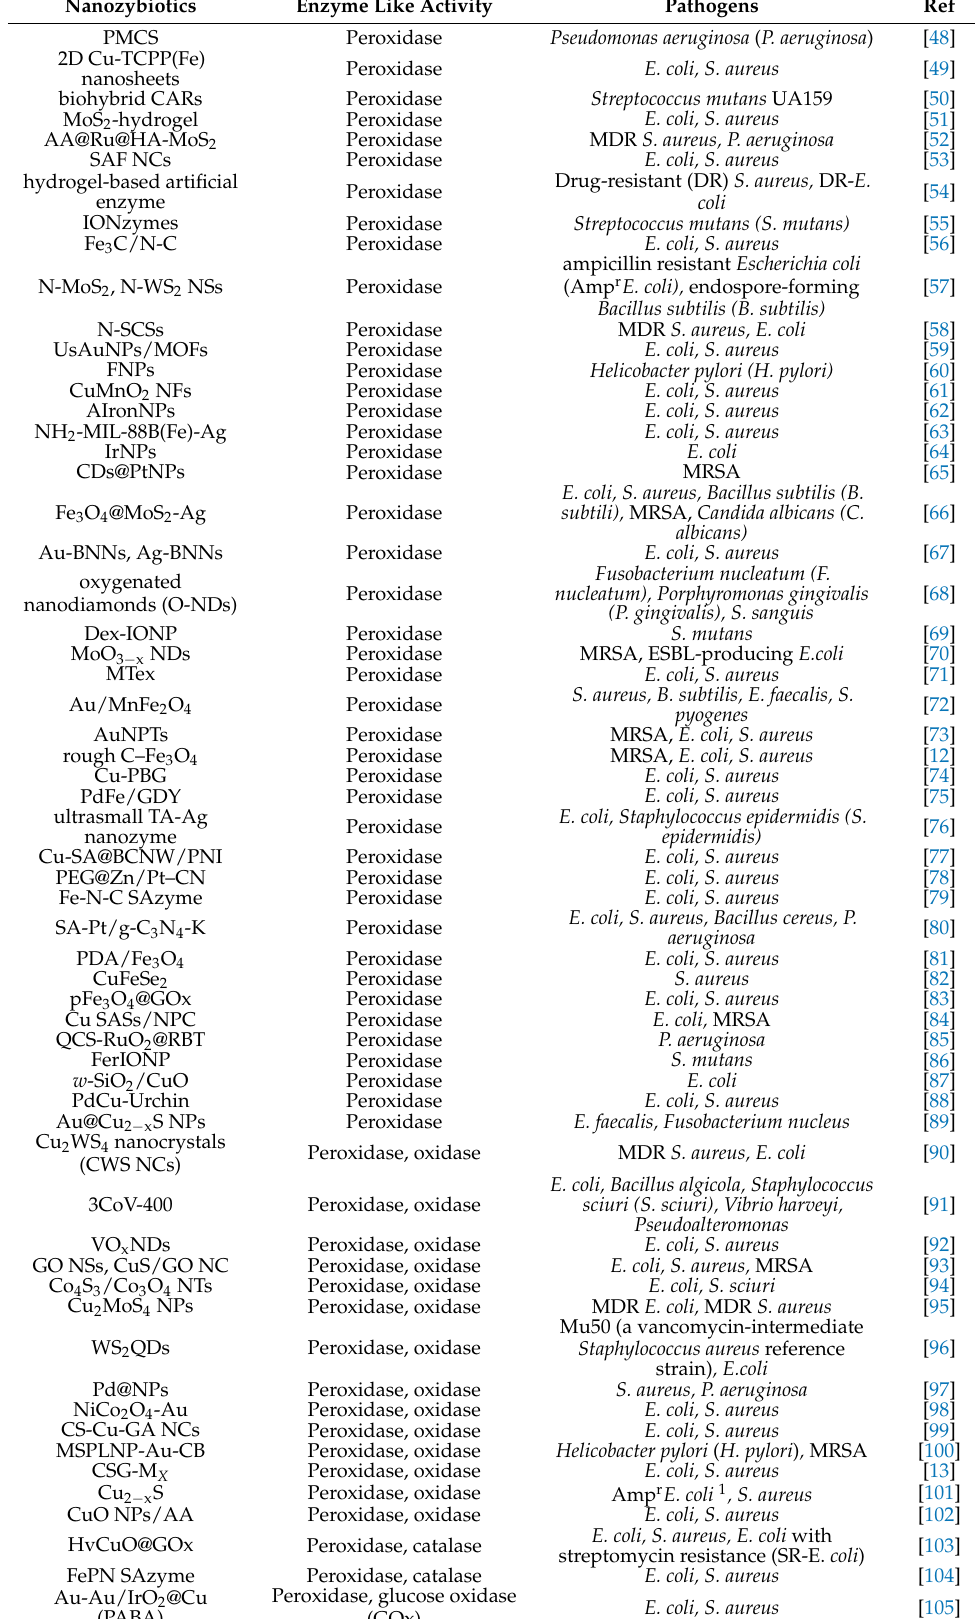
Table 1. An overview of nanozybiotics as